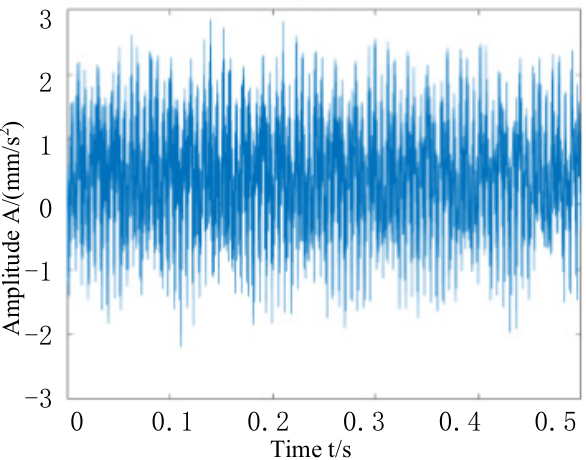
Figure 25. Time-domain waveform of the harmonic components extracted by adapOMP.